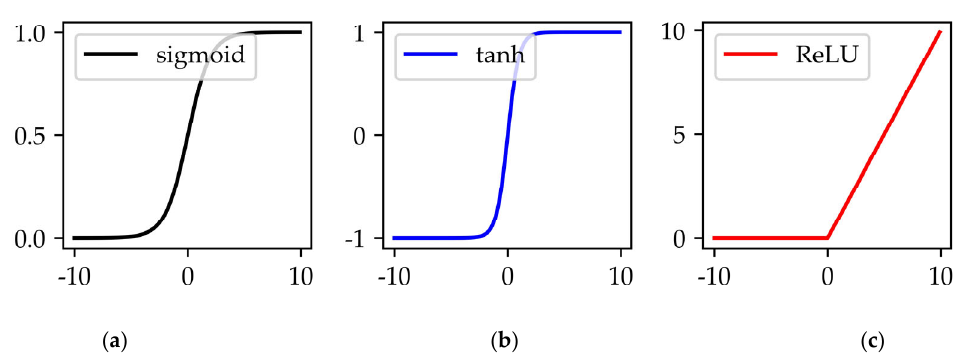
( c ) Figure 6. Comparison of Recurrent Neural Network (RNN), Long Short ‐ Term Memory (LSTM), and Gated Recurrent Unit (GRU): ( a ) RNN; ( b ) LSTM; ( c ) GRU. The cell state ( T c ) is a conveyor belt running through the top of the LSTM cell, which controls